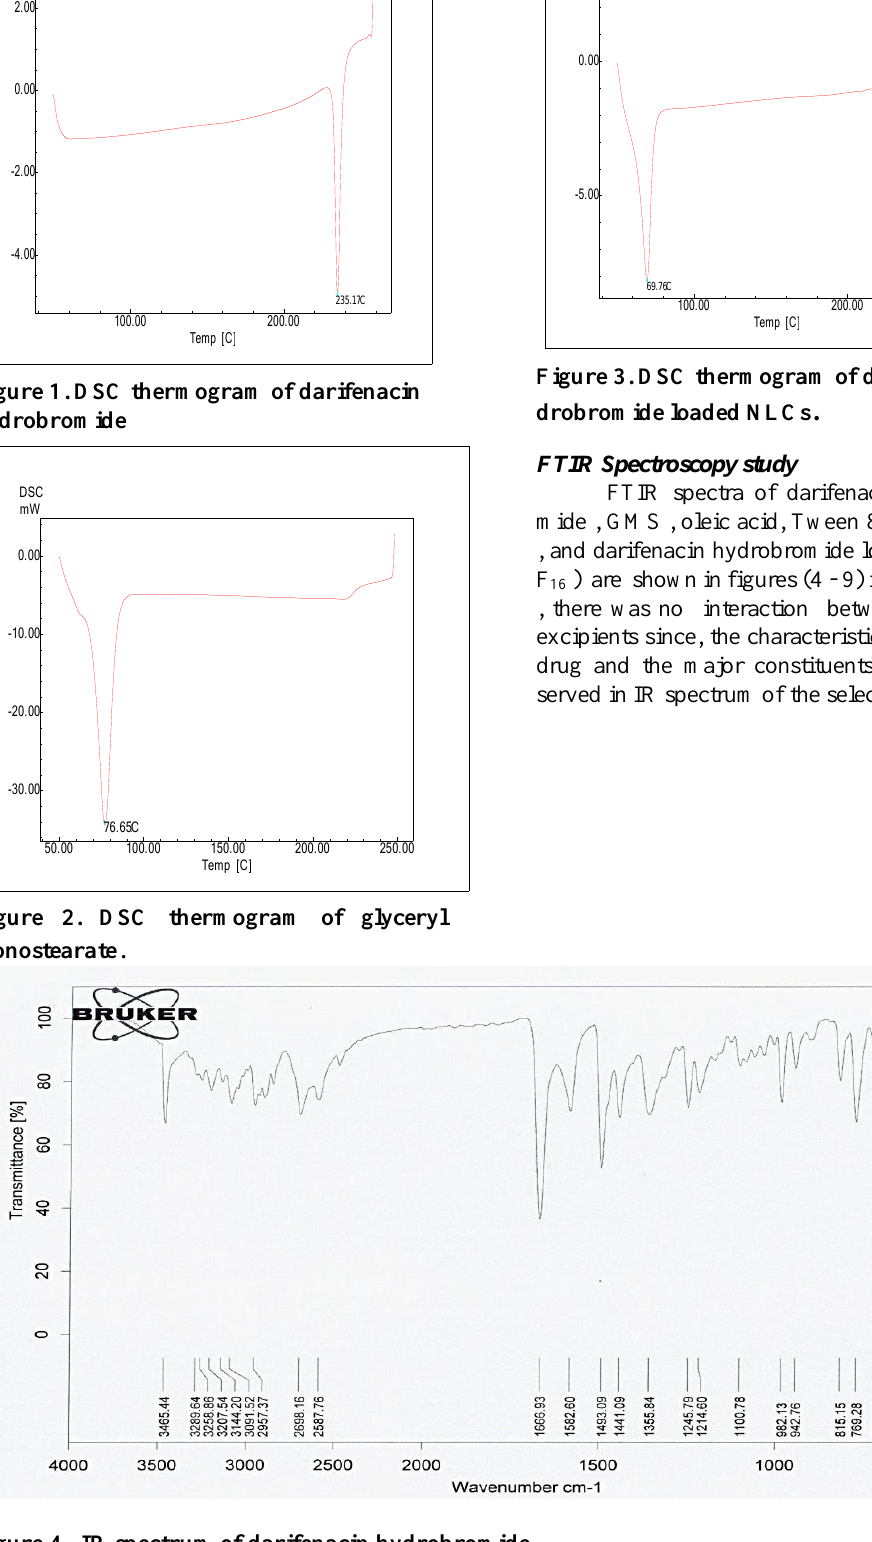
Figure 4 . IR spectrum of darifenacin